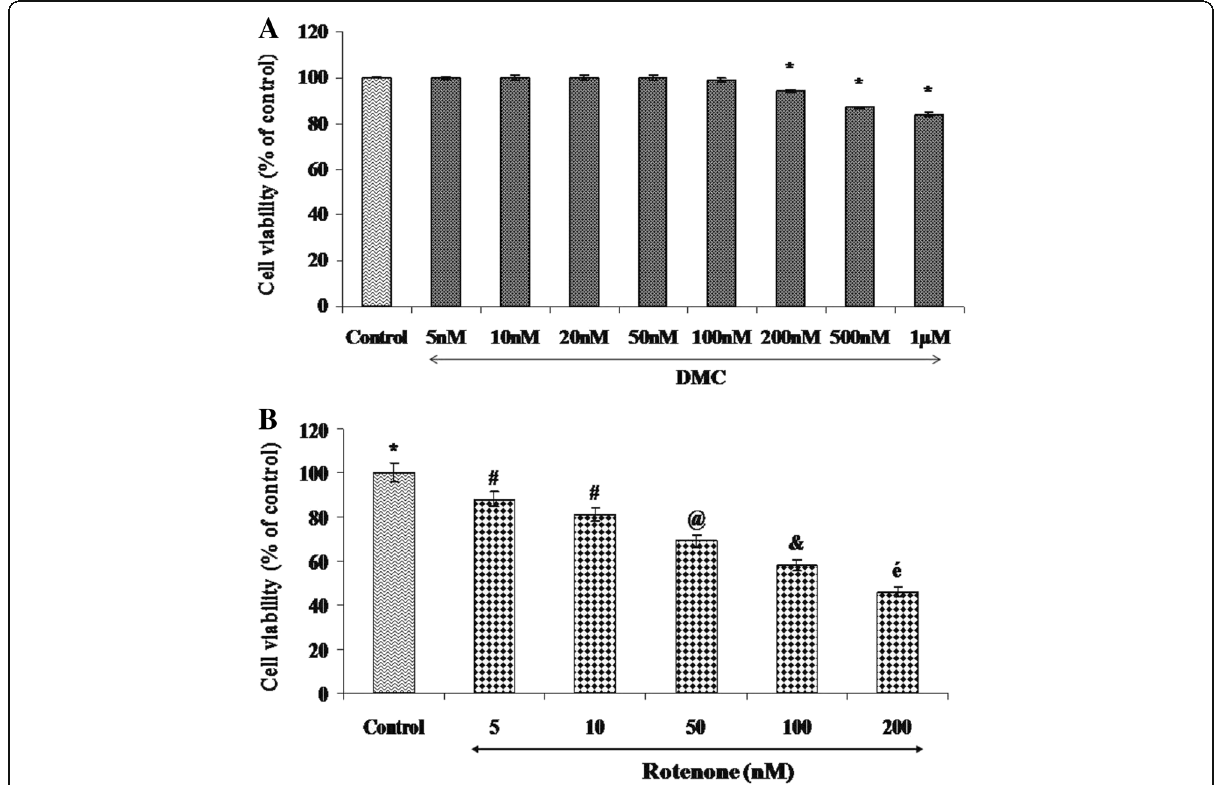
Fig. 2 Effect of DMC on rotenone induced cytotoxicity in SH-SY5Y cells. a shows the dose dependent effect of DMC at various concentrations (5 nM, 10 nM, 20 nM, 50 nM, 100 nM, 200 nM, 500 nM and 1 μ M). Up to 50 nM did not induce any toxicity after 24 h treatment, whereas slight toxicity was induced at 1 μ M concentration. b shows the dose-dependent effect of rotenone (5, 10, 50, 100, and 200 nM) induced cell toxicity after 24 h. An approximately half-maximal inhibition of cell viability was obtained at 100 nM rotenone concentration. Values are expressed as the percentage of the untreated control and represented as mean ± SEM of four independent experiments in each group. Values not sharing a common superscript are significant with each other ( p